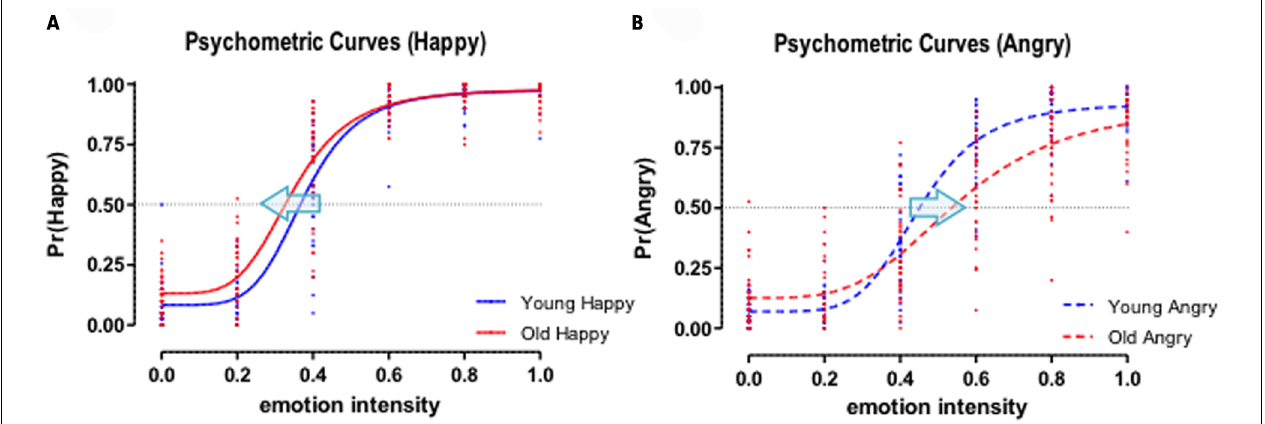
FIGURE 5 | (A) Psychometric curves for happy decisions. (B) Psychometric curves for angry decisions. Psychometric curves were fitted by using the Naka-Rushton response function. A leftward shift (blue arrow) represents the decrease of perceptual decision threshold (C 50 parameter) for old facial